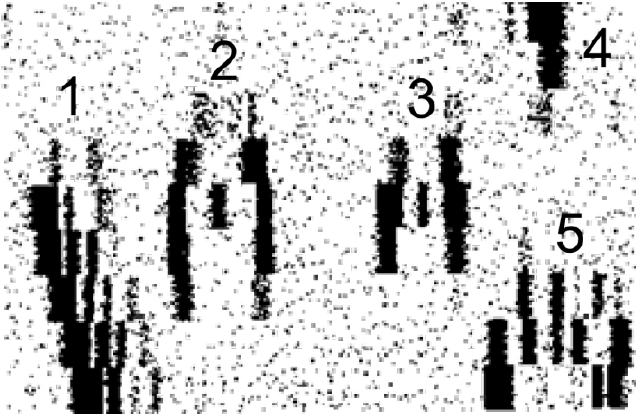
Figure 13. Radar images recorded by a wide-span mine detector.